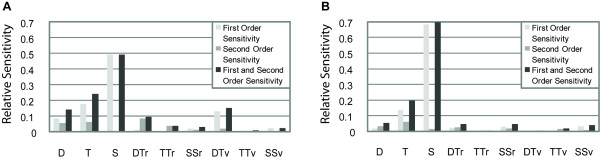
Sensitivity analysis using the HDMR global sensitivity method on the thermodynamic model of Zinzen et al. First-, second- and the sum of first- and second-order sensitivity indices (scaled from 0.0 to 1.0), are shown. Despite the focus in the Zinzen et al. study on Dorsal-Twist cooperativity, these parameters are relatively insensitive compared to protein scaling factors. Results from representative enhancer structures: A) set 1 and B) set 2. The model parameters are shown on the horizontal axis. D, T, and S correspond to scaling factors for Dorsal, Twist, and Snail binding sites, respectively. DTr, TTr, and SSr correspond to cooperativity parameters representing Dorsal-Twist, Twist-Twist, and Snail-Snail cooperativities respectively, for the rho-like enhancer. Similarly, DTv, TTv, and SSv correspond to cooperativity parameters representing Dorsal-Twist, Twist-Twist, and Snail-Snail cooperativities respectively, for the vnd-like enhancer.